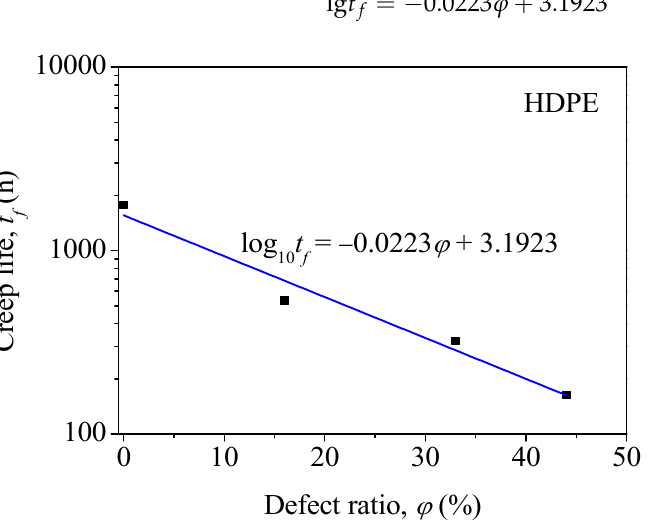
Figure 8. Variation of creep life with the defect ratio for the HDPE specimen under a load of 9 MPa and at a temperature of 40 °C.